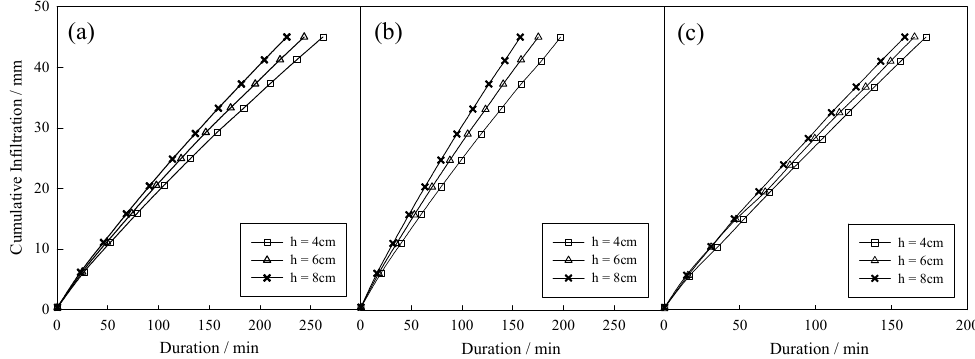
Figure 7. Infiltration pattern curves under different irrigated water depths: ( a ) silt loam, γ d = 1.30 g·cm − 3 ; ( b ) sandy loam, γ d = 1.35 g·cm − 3 ; and ( c ) loamy sand.